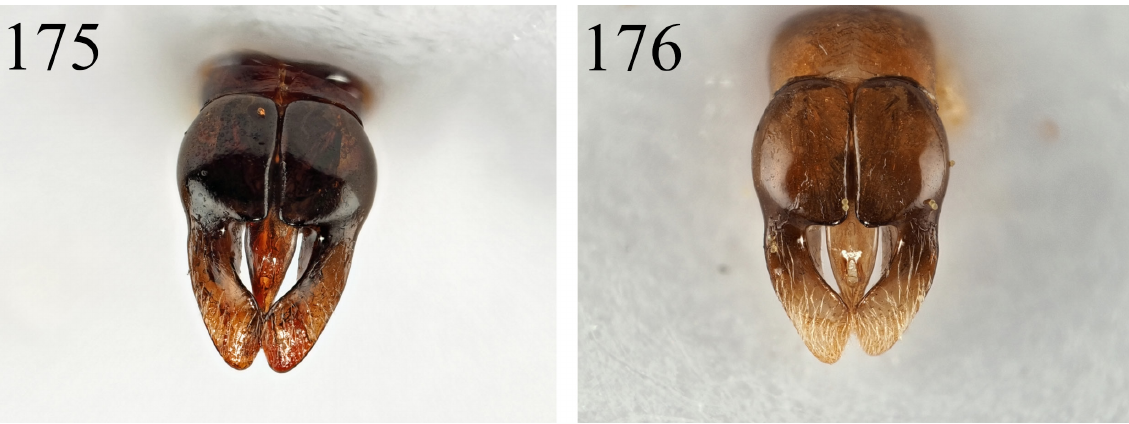
Figs 175–176. Andrena zostera Warncke, 1975. 175 . Male genitalia, specimen from Syria (TJWC). 176 . Male genitalia, specimen from Uzbekistan